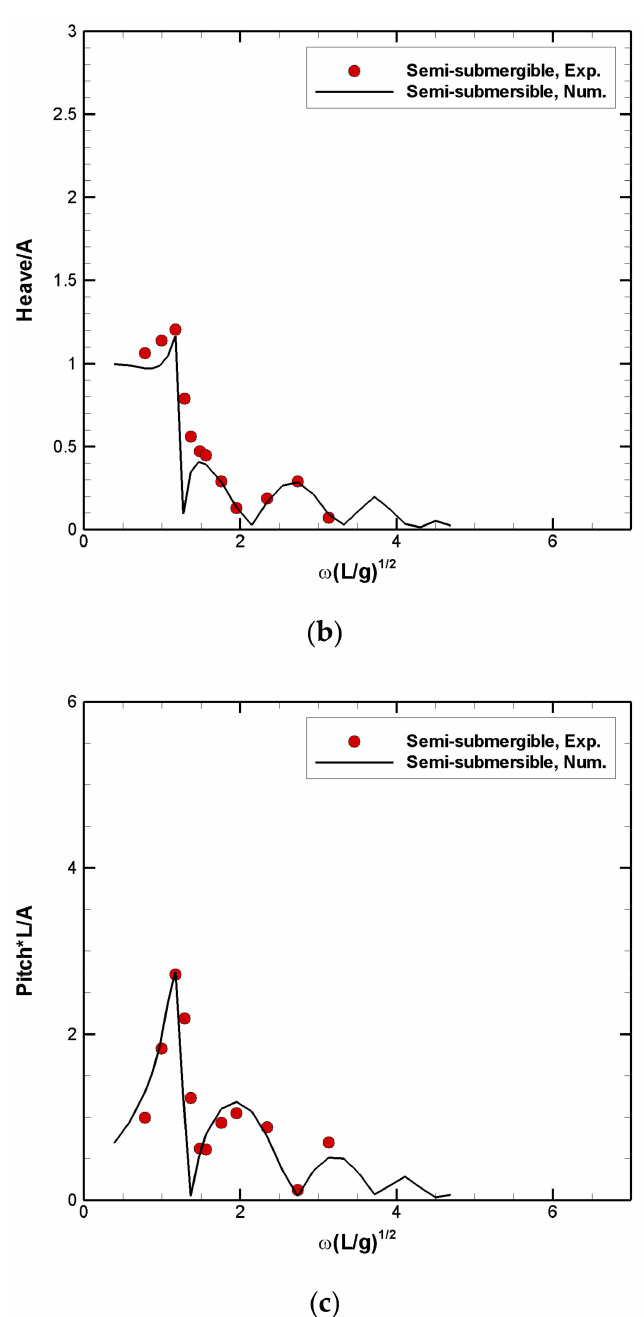
Figure 17. Motion RAO of large semi-submersible (wave heading angle = 0 ◦ ); ( a ) Surge; ( b ) Heave; ( c )